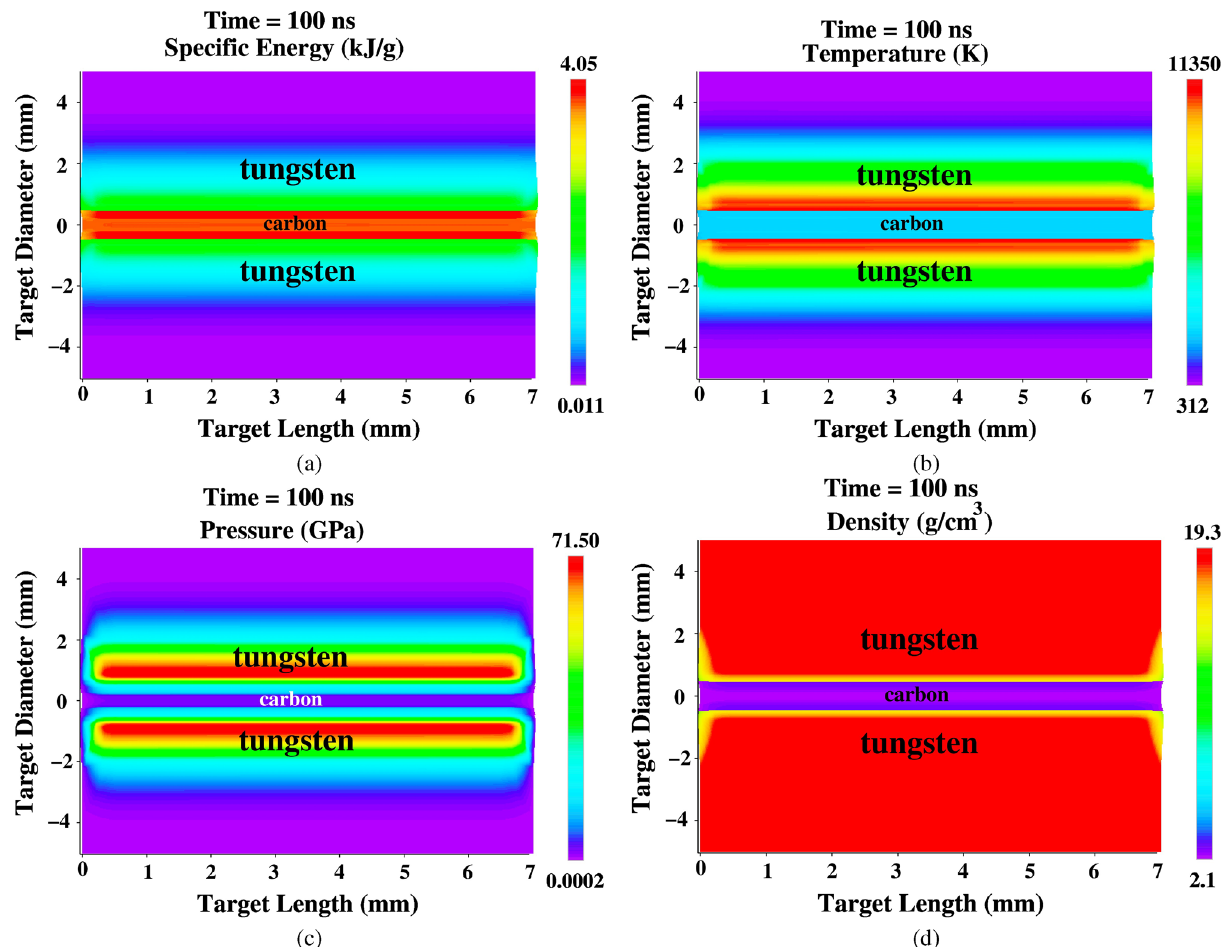
Figure 7. Target physical conditions generated by the BIG2 code at t = 100 ns, sample radius R si = 0.5 mm, outer target radius, R o = 5 mm, target length = 7 mm, bunch intensity = 3 × 10 11 uranium ions, bunch length = 200 ns, ion energy = 2 GeV/u, ( a ) specific energy, ( b ) temperature, ( c ) pressure and ( d )